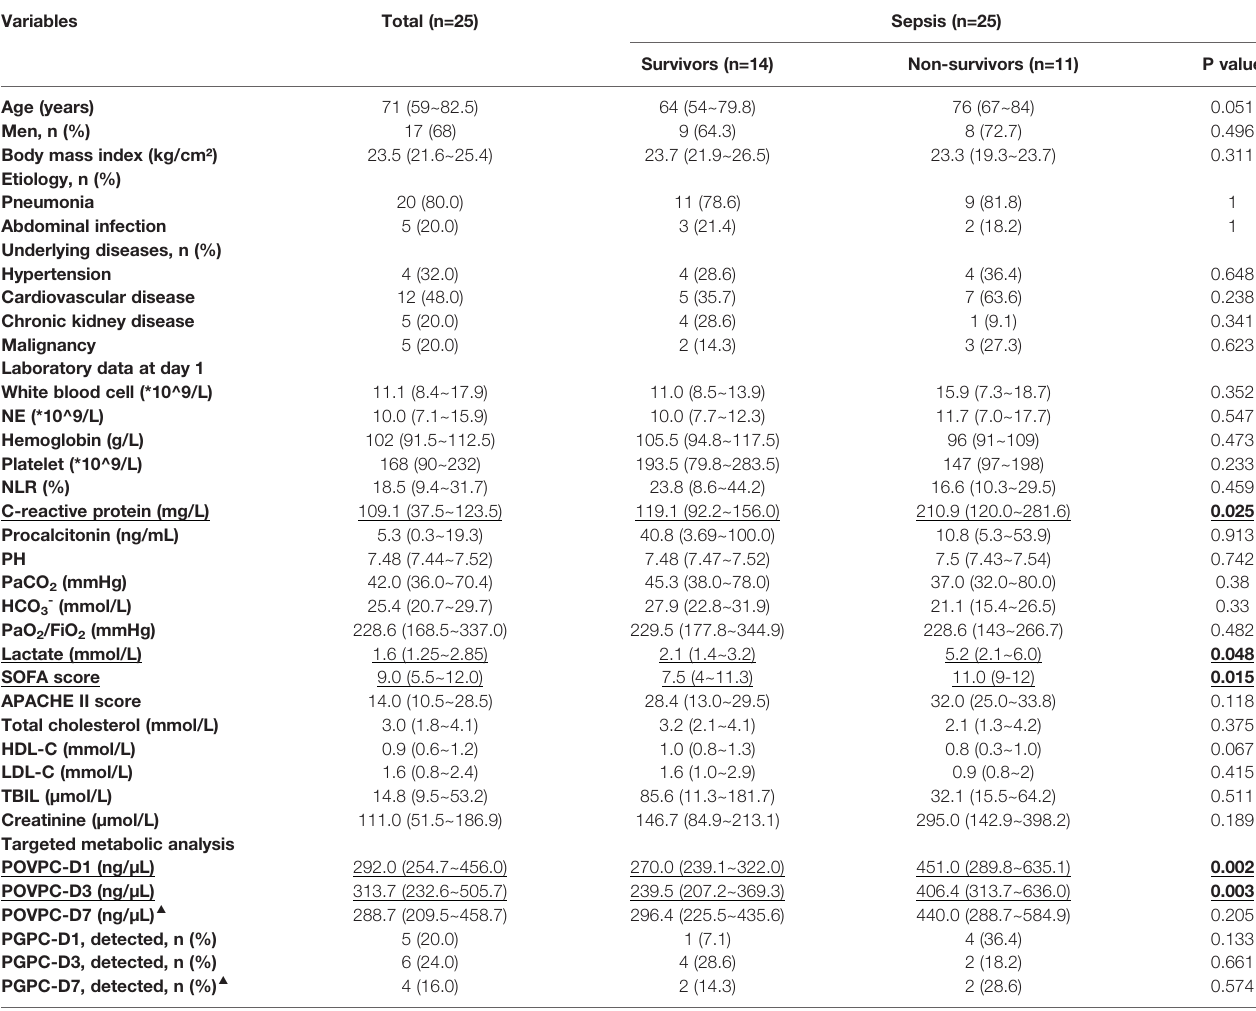
TABLE 2 | Characteristics of septic survivors and septic non-survivors.